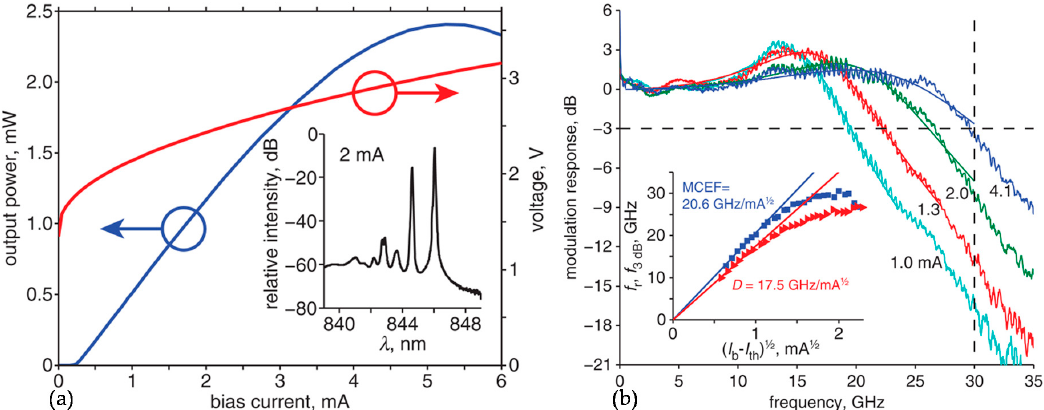
Figure 1. ( a ) Light-current-voltage characteristics (Inset: optical spectrum at a bias current of 2-mA); ( b ) small-signal modulation responses at bias currents of 1-mA, 1.3-mA, 2-mA, and 4.1-mA (Inset: resonance frequency f r and 3-dB bandwidth f 3dB of VCSEL plotted against square root of bias current I b above threshold I th ); I b : bias current; I th : threshold current; D -factor: a rate factor consisting of resonance frequency f r and square root of current I b - I th ; MCEF: the modulation current efficiency factor; (From [30], © 2015 IEEE). Table 1. Incomplete summary of SM-/MM-VCSEL applied in beyond 100-Gbit/s per lane data transmission. Tx